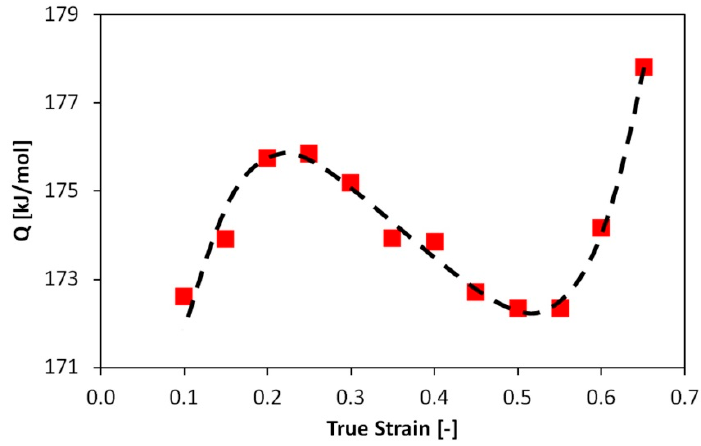
Figure 9. E ff ect of the true strain on the Q value of the homogenized 6082 alloy, according to Reference [45].